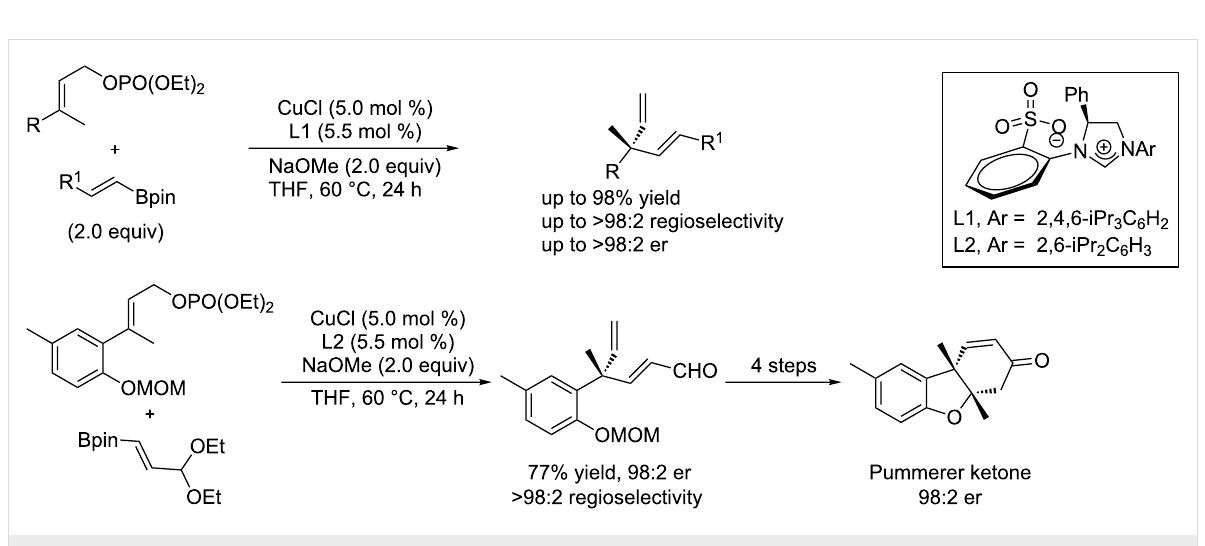
Scheme 27: Allylic substitution of allyl phosphates with